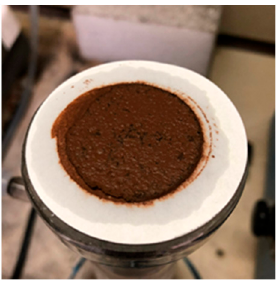
Figure 6. Schematic of residues on filter paper after suction filtration.